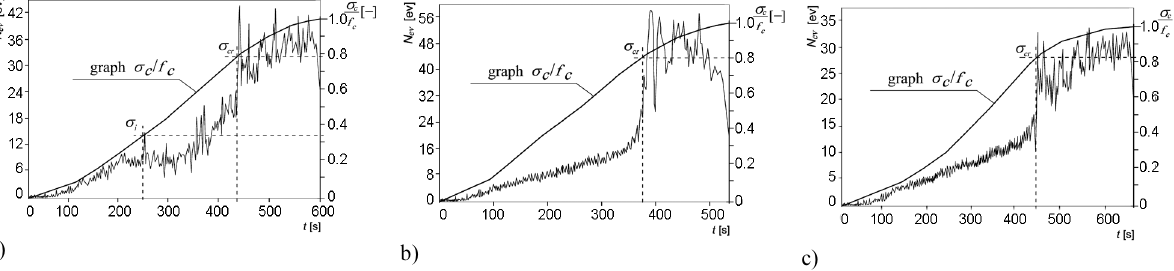
Fig. 4. Rate of AE events ( N ev ) versus failure time for fibre-reinforced concrete: a) not containing steel fibres (SF); b) containing 1% of steel fibres (F1), c) containing 3% of steel fibres (F3) (Błaszczyński et al. 2008; Przybylska-Fałek 2013)